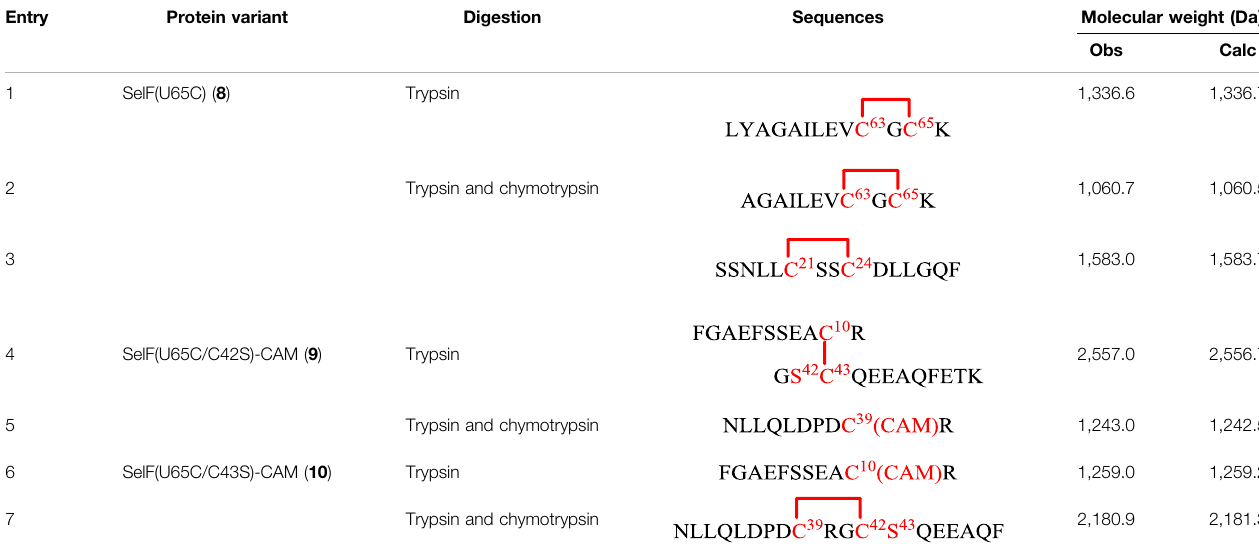
TABLE 1 | Disul fi de bond elucidation through the enzymatic digestion of SelF(U65C) ( 8 ), SelF(U65C/C42S)-(CAM) ( 9 ) and SelF(U65C/C43S)-(CAM) ( 10